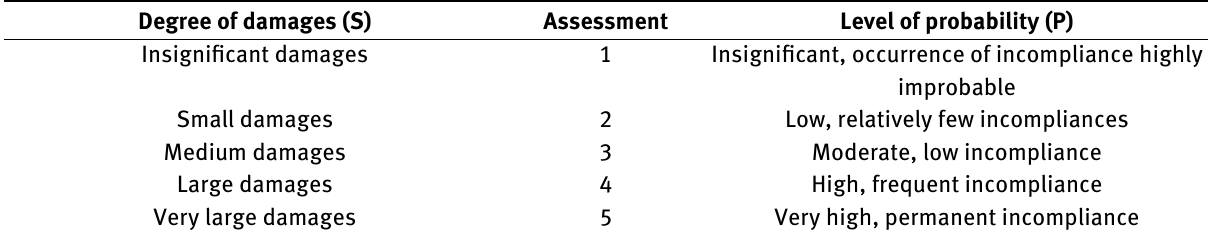
Table 1: Assessment of a degree of losses in a Preliminary Hazard Analysis (PHA) method